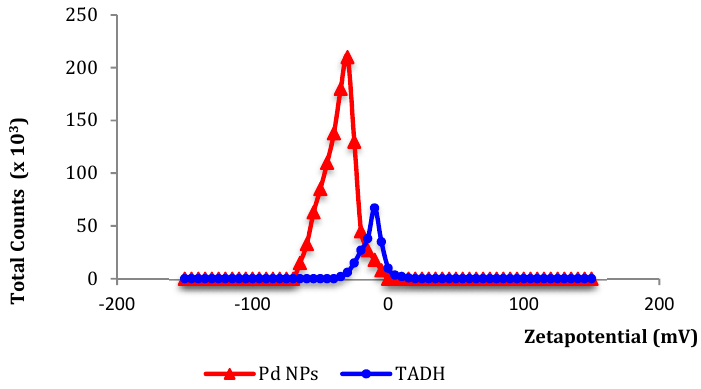
Figure 4. Distribution of the net charge of TADH ( − 10 mV) and Pd NPs ( − 28 mV).